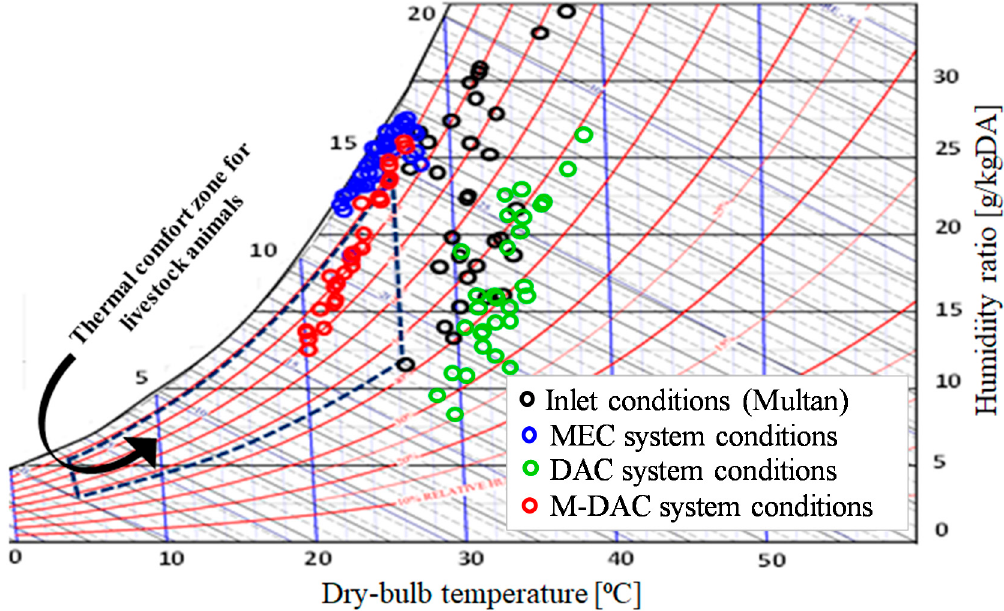
Figure 7. Psychrometric based feasibility analysis of proposed AC system options in terms of relative humidity (RH) and temperature (T) for month of July.